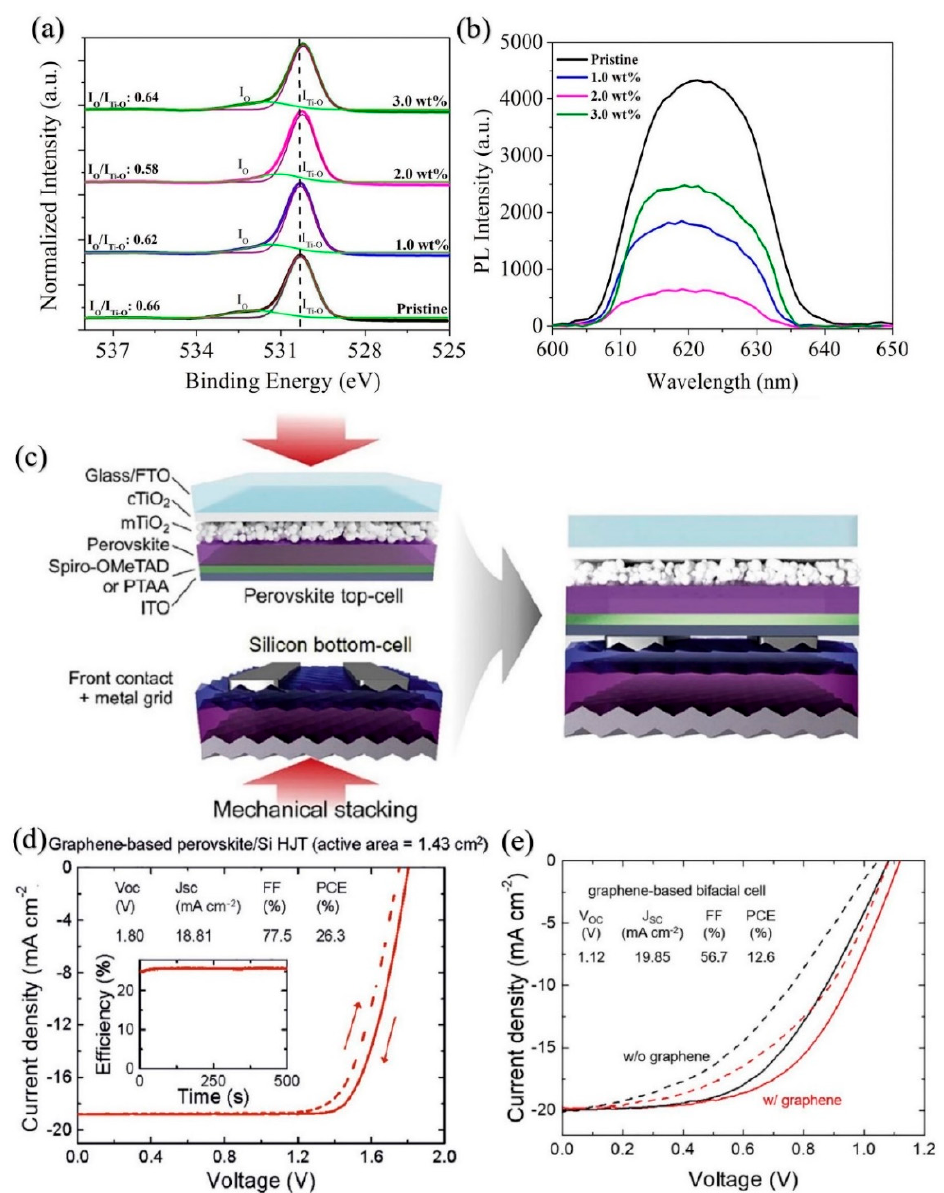
Figure 4. ( a ) O 1s XPS spectra for TiO 2 of di ff erent graphene nanoplatelets (GNP) additions, ( b ) photoluminescence (PL) spectra of TiO 2 of di ff erent GNP additions [17] (republished with permission from American Chemical Society), ( c ) schematic of cross section of two-terminal perovskite / silicon heterojunction (JHT) tandem solar cell by mechanical stacking of layers and uniaxial pressing, ( d ) J-V characteristics and parameters measured for tandem solar cell (inset shows stabilized (PCE)), ( e ) J-V characteristics and parameters measured for bifacial PSC with and without graphene (GR) in the TiO 2 bilayer ETL [79] (republished with permission from